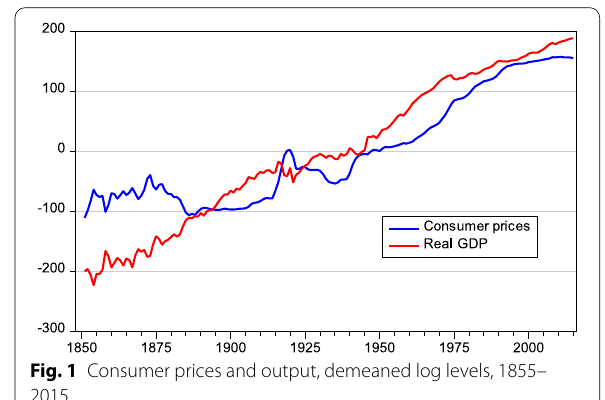
Fig. 1 Consumer prices and output, demeaned log levels, 1855–